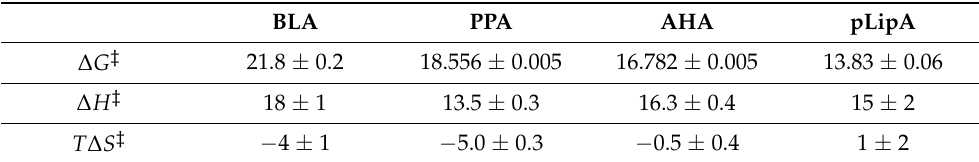
Table 2. Thermodynamic parameters of the activation barrier to the enzymes BLA, PPA, AHA and pLipA given in kcal/mol as calculated by the ThermoSlope software with standard errors calculated from the confidence intervals of the Arrhenius plot.